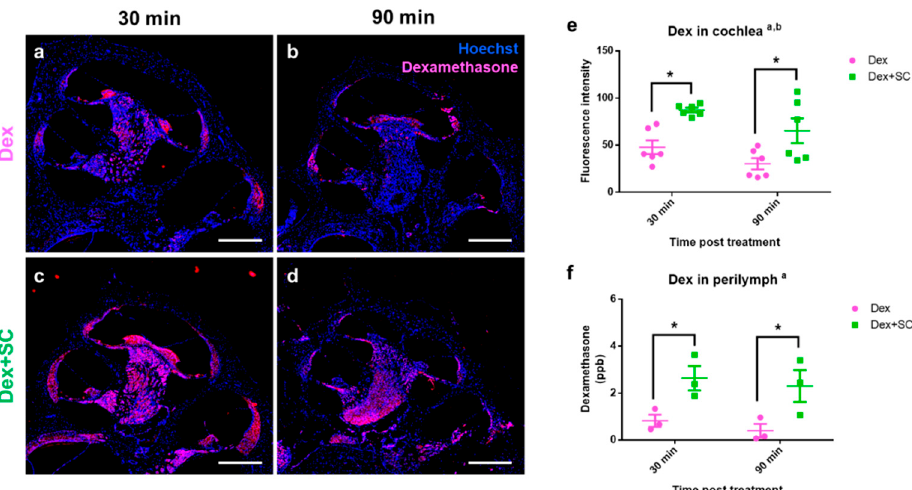
Figure 3. Dexamethasone uptake was enhanced by sodium caprate co-treatment in the cochlea as well as in the perilymph. ( a – d ) Cochlear tissues were collected from dex ( a , b ) and dex + SC ( c , d ) groups at 30 and 90 min post-treatment. Immunohistochemistry for dexamethasone (red) and nucleus (Hoechst, blue) staining revealed the presence of dexamethasone in the cochlear tissue after treatment. Sodium caprate co-treatment significantly increased dexamethasone uptake to the tissue at both time-points as compared to the dexamethasone-only group. Scale bar = 500 µm. ( e ) Intensity analysis confirmed that sodium caprate co-treatment significantly increased dexamethasone uptake to the cochlea at 30 and 60 min as compared to the dexamethasone-only group. Mean ± SEM. Two–way ANOVA; Tukey’s multiple comparisons test; a, main effect of treatment; b, main effect of time; n = 6; * p < 0.05. ( f ) Intracochlear perilymph was collected from the dex or dex + SC group at 30 and 90 min post-treatment, and the dexamethasone concentration was analyzed by LC–MS/MS. The sodium caprate-cotreated group showed significantly higher dexamethasone concentration in the perilymph at both time-points as compared to the dexamethasone-only group. Mean ± SEM. Two–way ANOVA; Fisher’s LSD; a, main effect of treatment; n = 3; * p <